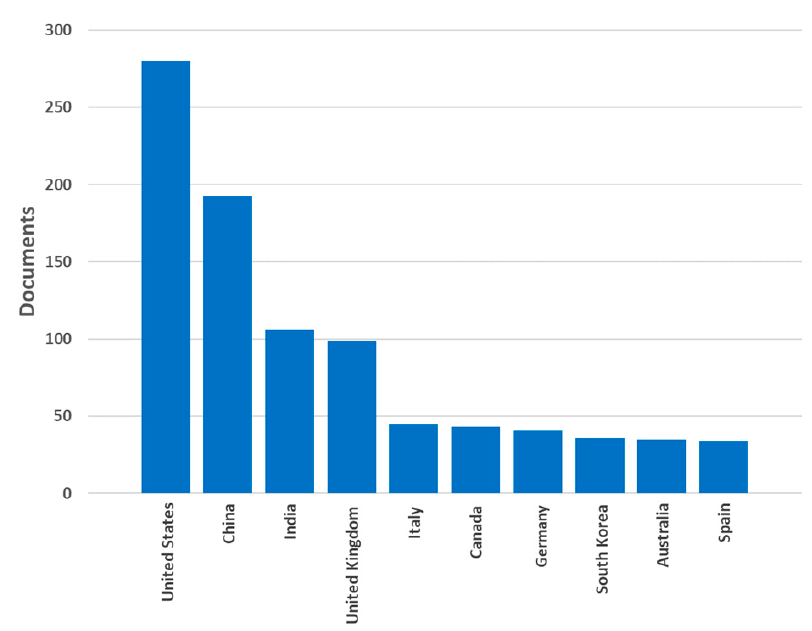
Figure 2. Documents per year by source.